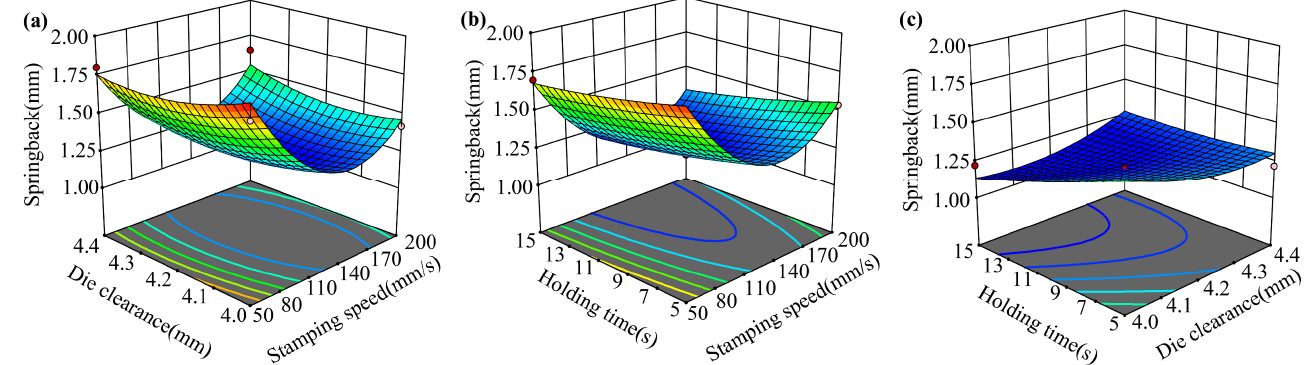
Figure 11. The effect of the two-factor interaction on the springback: ( a ) A–B; ( b ) A–C; ( c ) B–C.